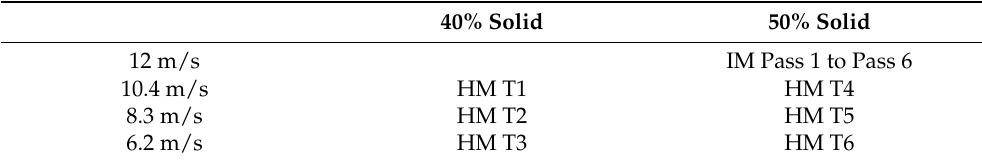
Table 3. Operating conditions of HIGMill (HM) and IsaMill (IM)